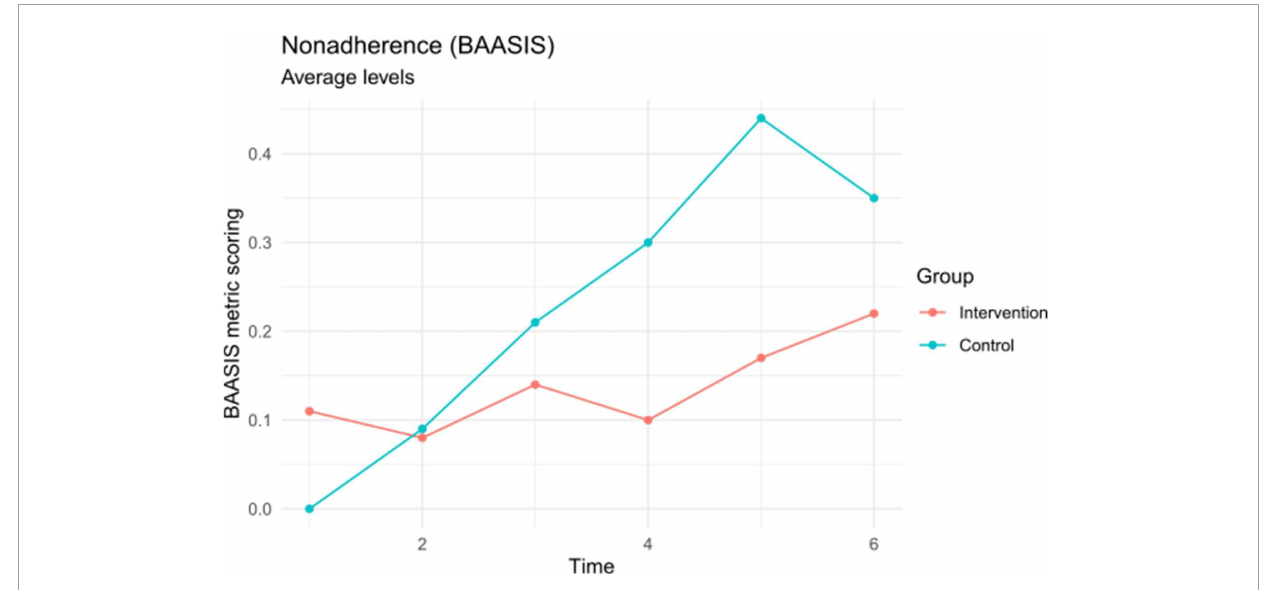
FIGURE3 Non-adherence as assessed by the basel assessment of adherence to immunosuppressive medications scale (BAASIS) (metric scoring). Mean differences are displayed for descriptive purposes and not statistically significant (see Table 2 ).